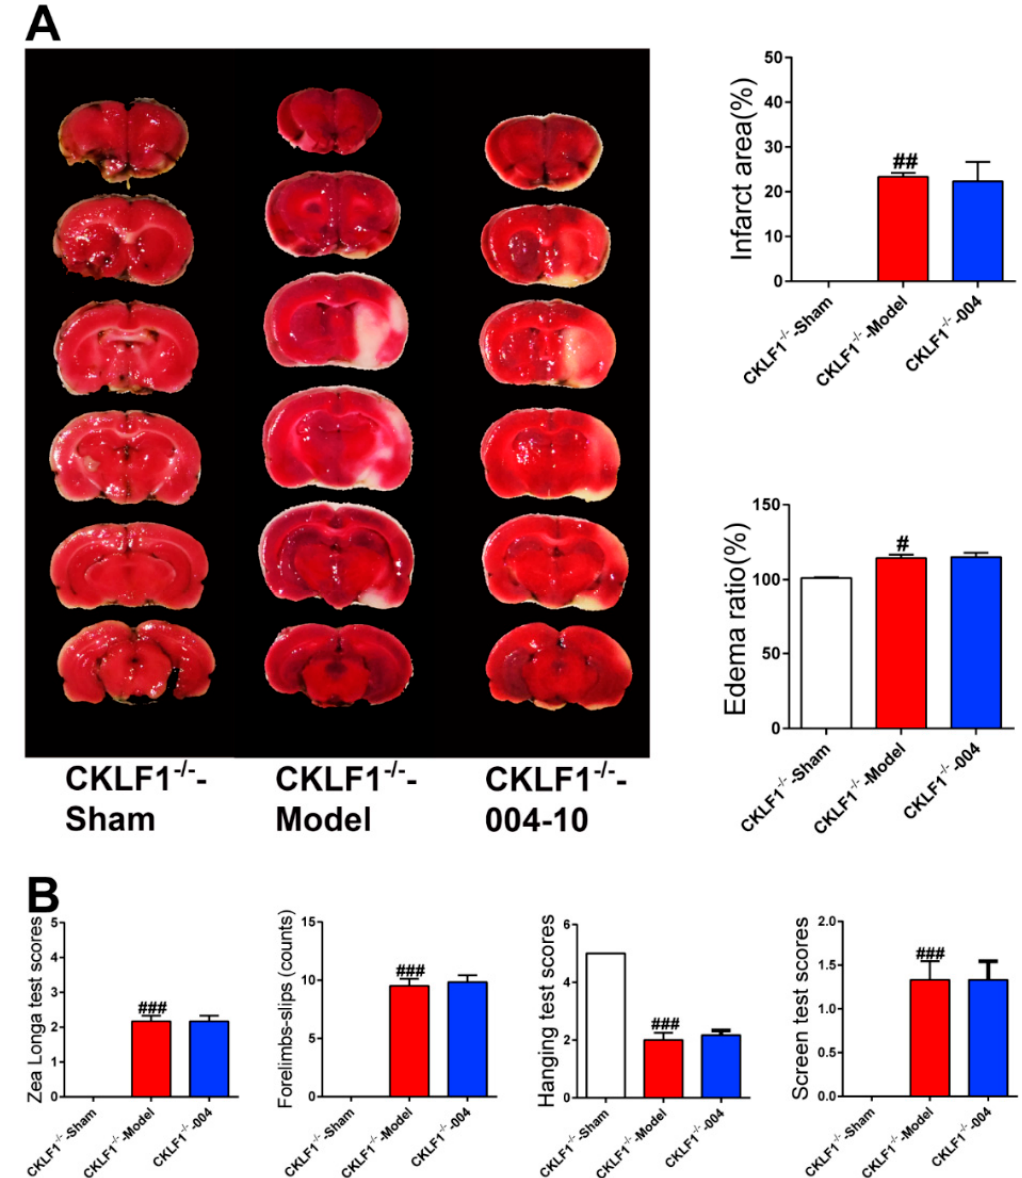
Figure 13. CKLF1 is necessary for IMM-H004 to exert protective effects against brain ischemia. ( A ) Representative TTC staining images, and analysis of infarction area and edema ratio. ( B ) Statistical analysis of the Zea Longa test scores, forelimb slips, hanging test scores, and screen test scores in CKLF1 − / − rats. All the data are shown as the mean ± SD, a part of data are shown as the mean ± SD after normalization to the sham ( n = 6/group). # p < 0.05 vs. sham; ## p < 0.01 vs. sham; ### p < 0.001 vs. sham.